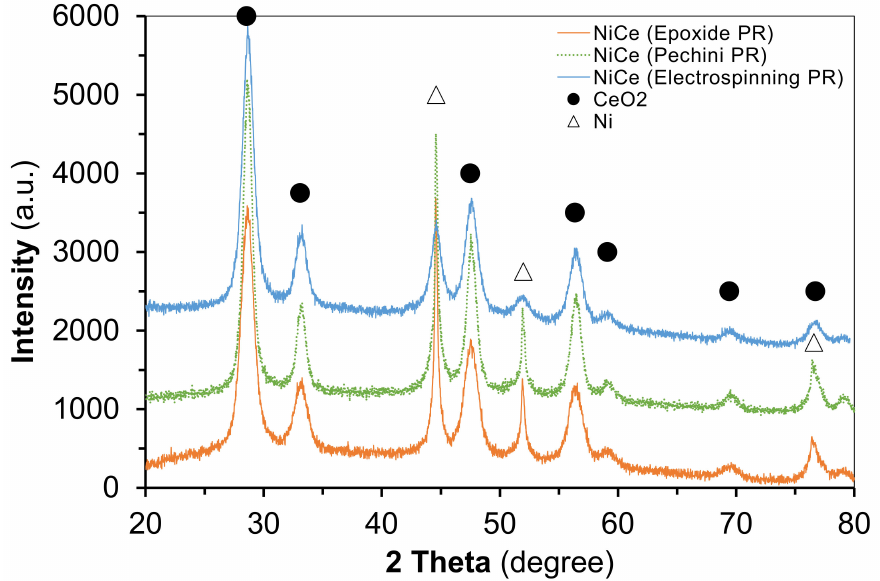
Figure 6. Nickel–cerium bimetallic oxides prepared by different methods: XRD analysis (powder) after tests under pressure over fresh